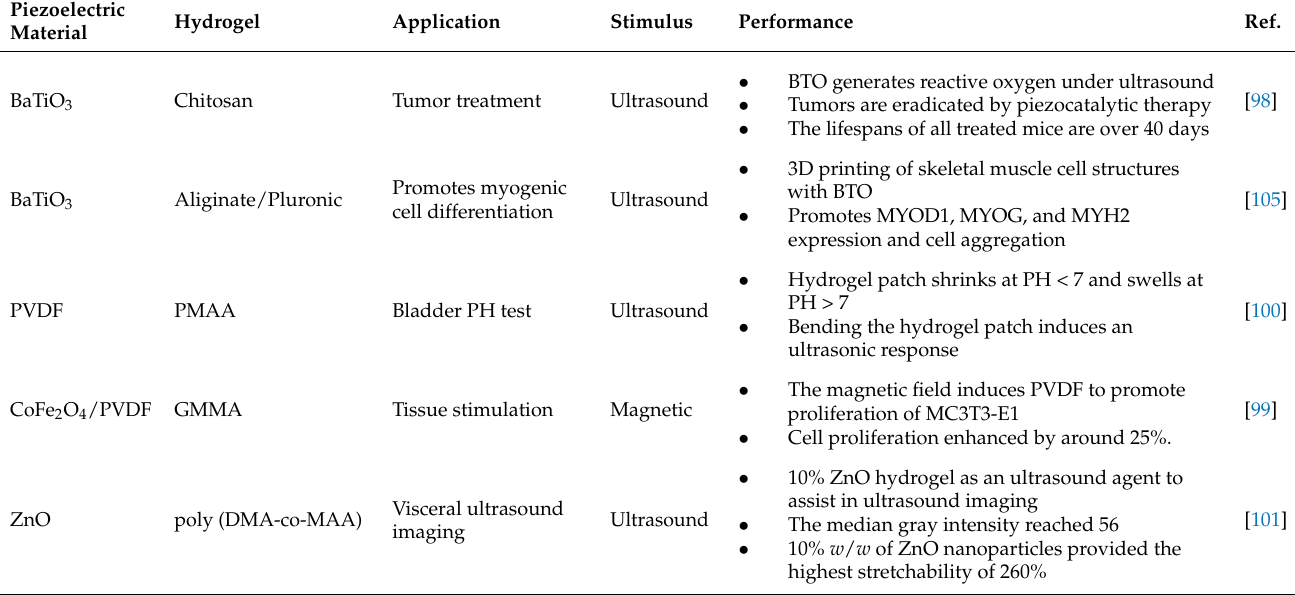
Table 4. Hydrogel-based piezoelectric devices for ultrasound stimulation, including different piezo- electric materials and hydrogels, the methods of stimulation, and related